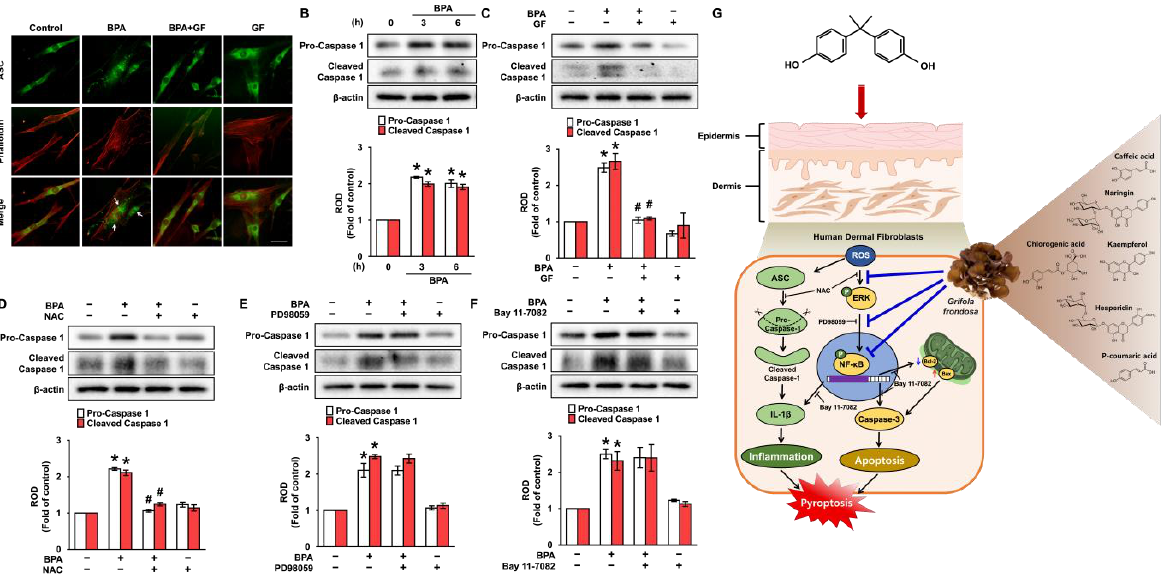
Figure 7. GF inhibits dermal fibroblastic pyroptosis caused by BPA. ( A ) The inhibitory effect of GF on ASC speck formation (green) confirmed by confocal microscopy is shown. Phalloidin was used for F-actin counterstaining (red). Scale bars, 100 µ m (magnification × 400). n = 4. ( B ) Time-dependent responses of expression of pro- and cleaved caspase-1 exposed by BPA are shown. n = 4. * p ≤ 0.01 vs. 0 h. ROD, relative optical density. ( C ) The inhibitory effects of GF on expression of pro- and cleaved caspase-1 in BPA-treated NHDFs are shown. n = 4. * p ≤ 0.01 vs. Cont. # p ≤ 0.05 vs. BPA alone. NHDFs were exposed to NAC ( D ), PD98059 ( E ), and Bay 11-7082 ( F ) for 30 min prior to BPA treatment for 6 h. n = 4. * p ≤ 0.05 vs. Cont. # p ≤ 0.01 vs. BPA alone. ( G ) The sequences of